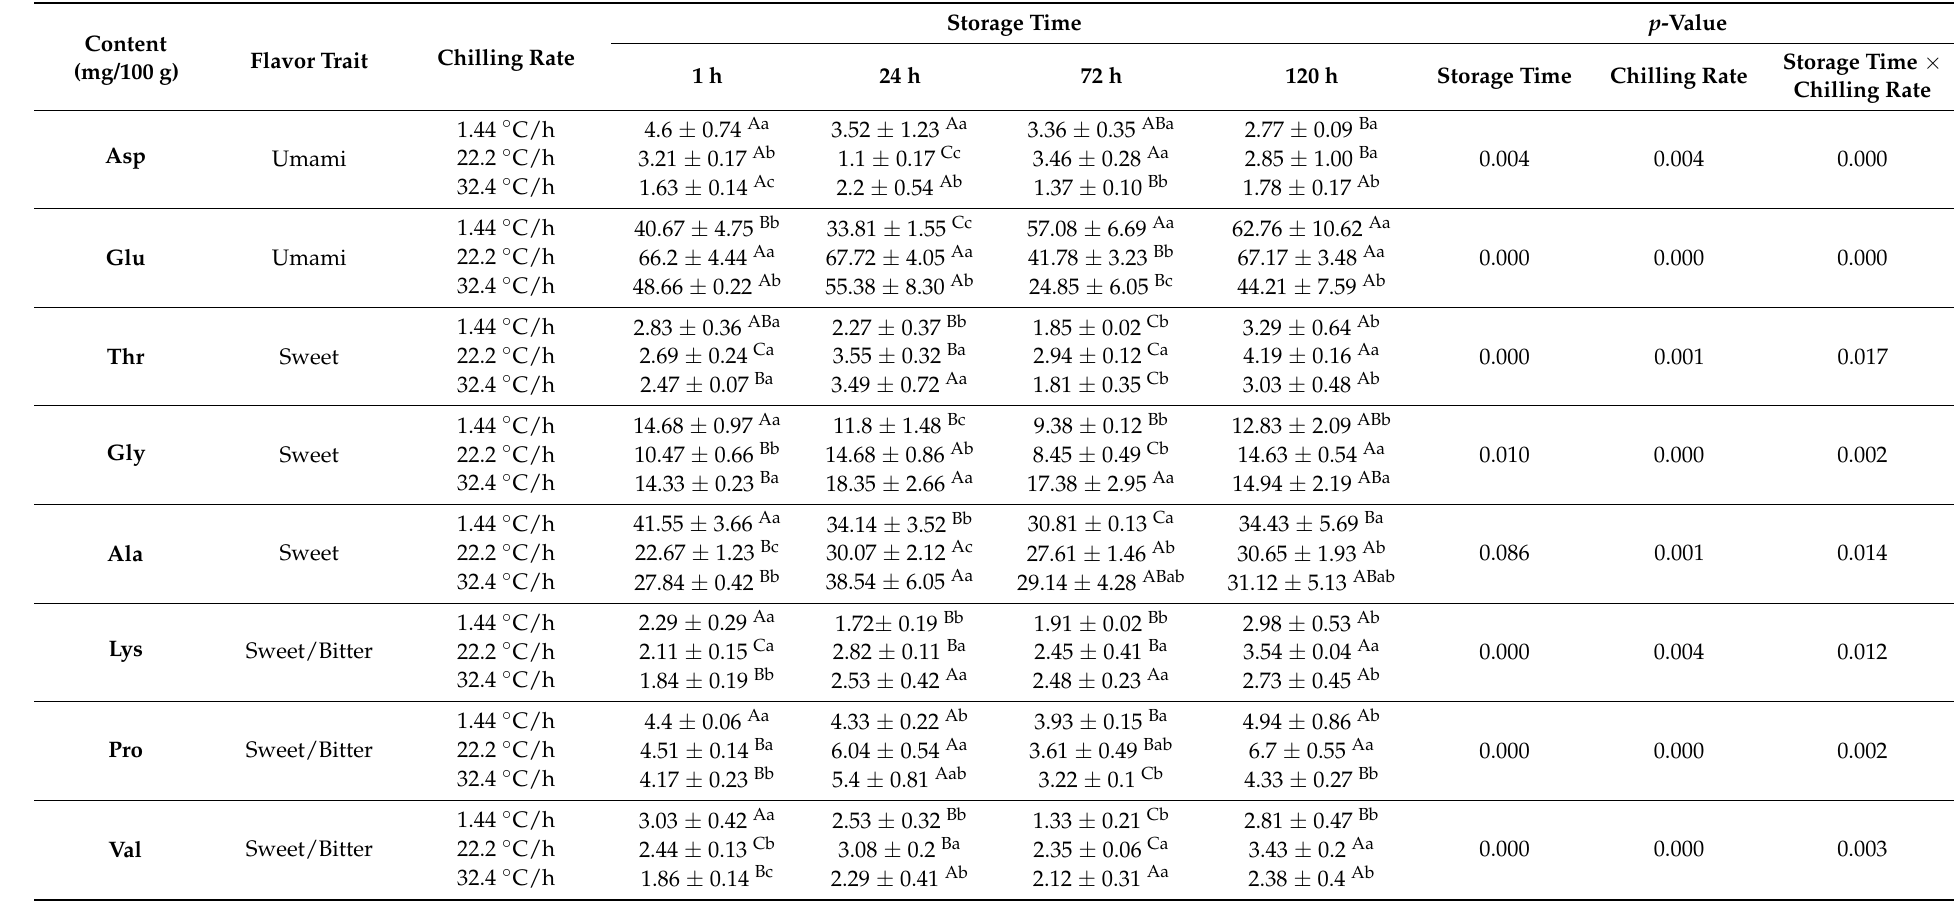
Table 2. Contents (mg/100 g) of free amino acid in raw meat at different chilling rates during